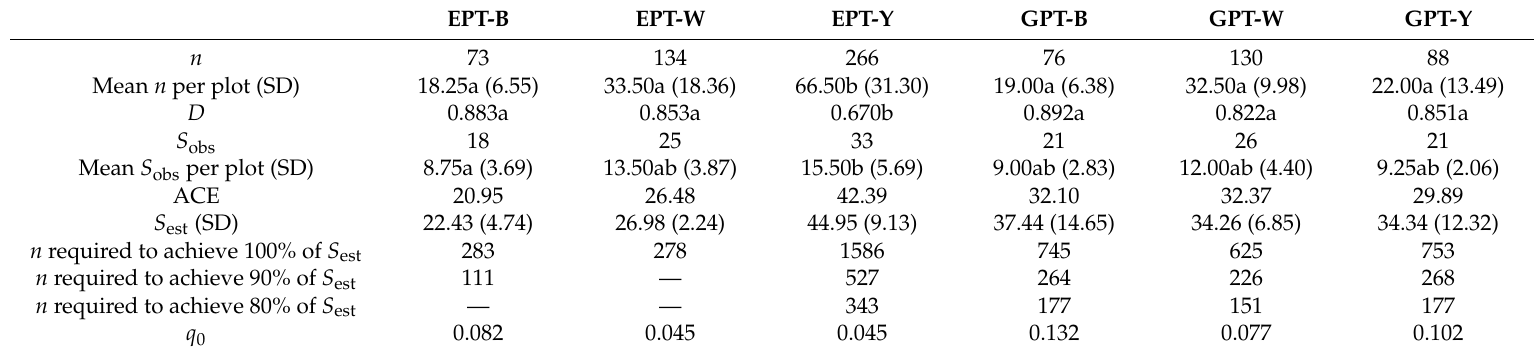
Table 2. Totals ( n ) and mean numbers of bees (with standard deviations), Simpson’s diversity indices (D), and totals ( S obs ) and mean bee species richness (with standard deviations) collected using six pan trap color/elevation combinations, with abundance coverage estimators (ACE) and Chao1 estimates ( S est , with standard deviations) of minimum asymptotic species richness, n required to achieve a specified percentage of S est , and probabilities of an additional individual being a previously undetected species ( q 0 ) in oak-hickory forest in Hancock County, IL, USA, April–September 2011. Means followed by different letters are significantly different ( p < 0.05, Holm-Sidak multiple comparison procedure); Simpson’s diversity values followed by different letters are significantly different ( t- tests; p -values for multiple comparisons adjusted using Holm’s step-down procedure). EPT-B = elevated blue pan trap, EPT-W = elevated white pan trap, EPT-Y = elevated yellow pan trap,